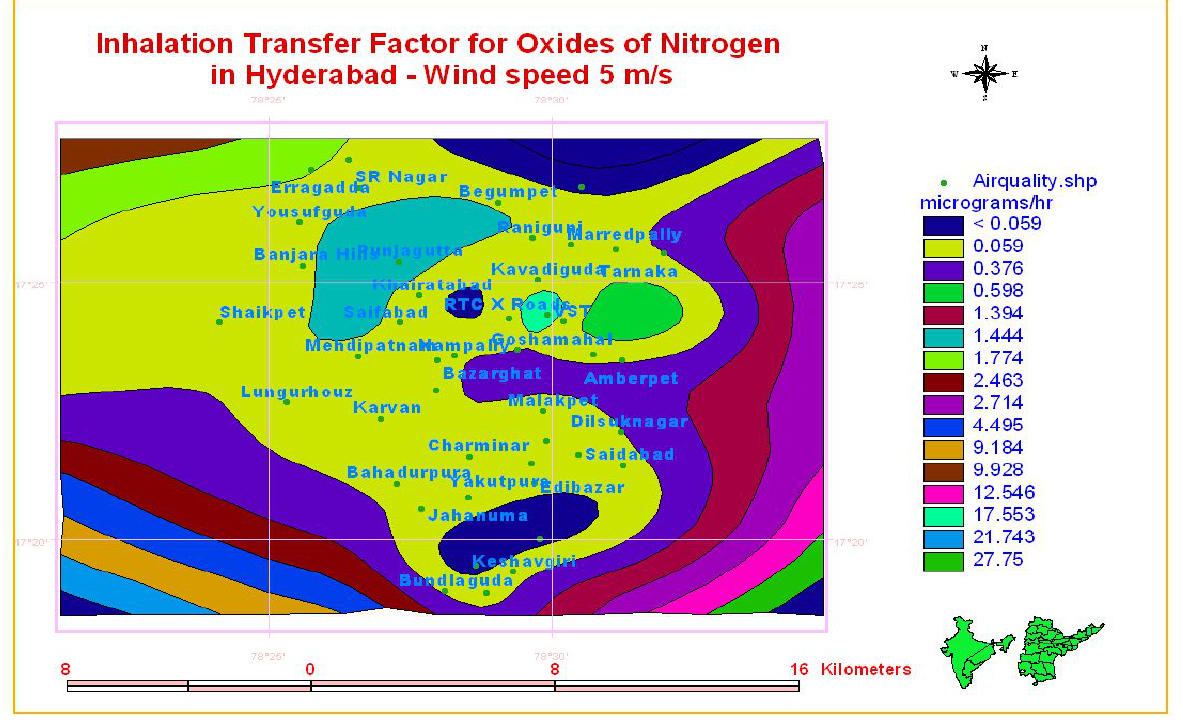
Figure 10: Inhalation transfer factor oxides of nitrogen in Hyderabad – wind speed 5m/s